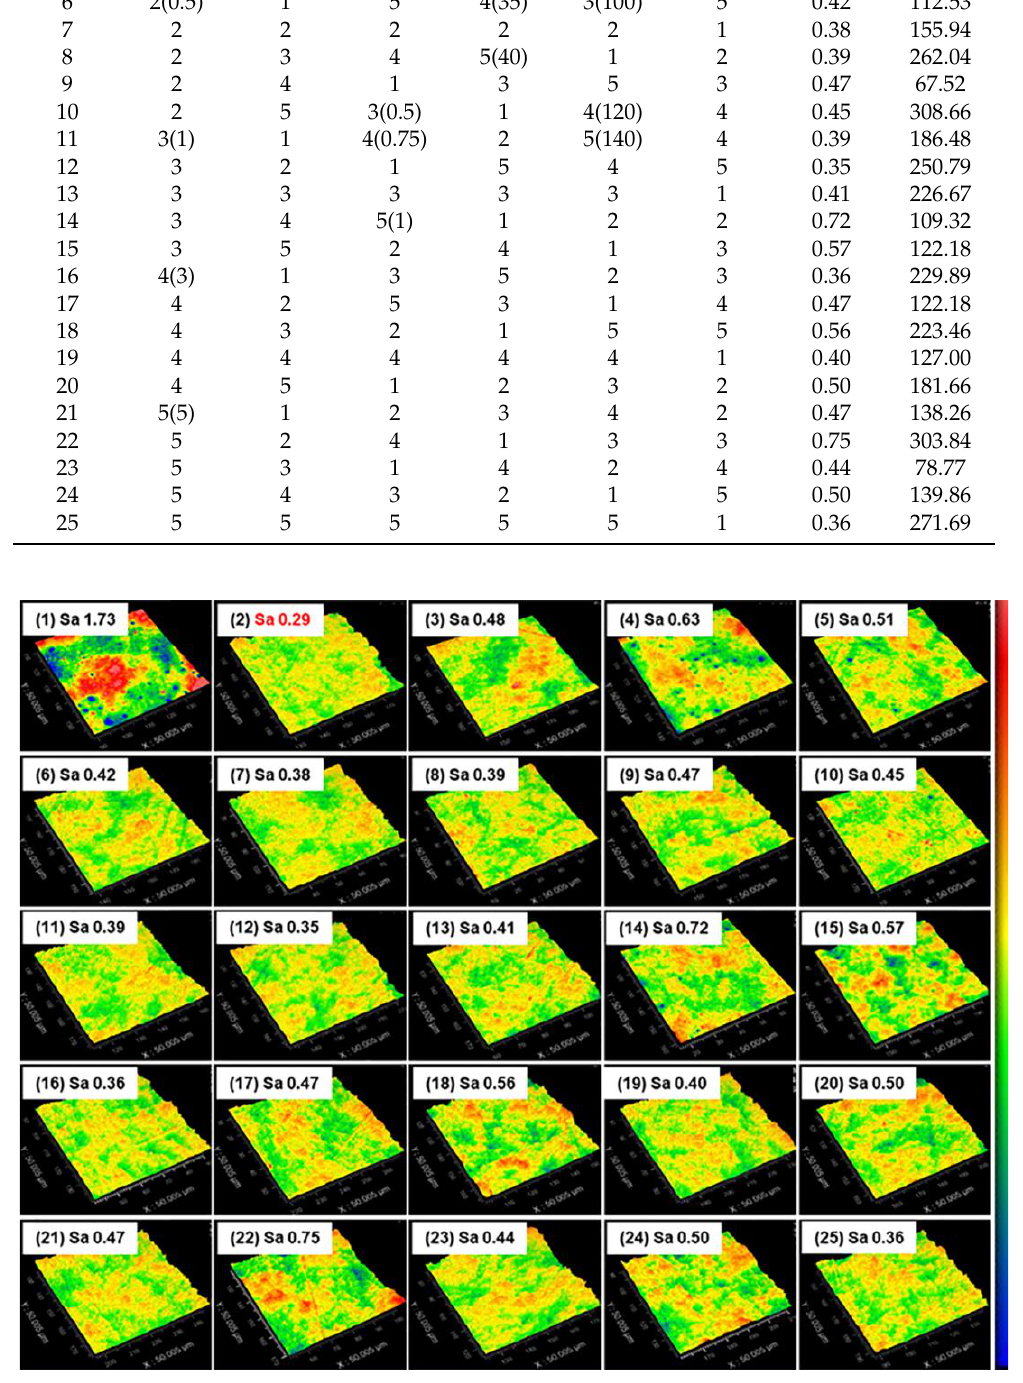
Figure A2. Optical microscopic images of the samples from the orthogonal experiment.